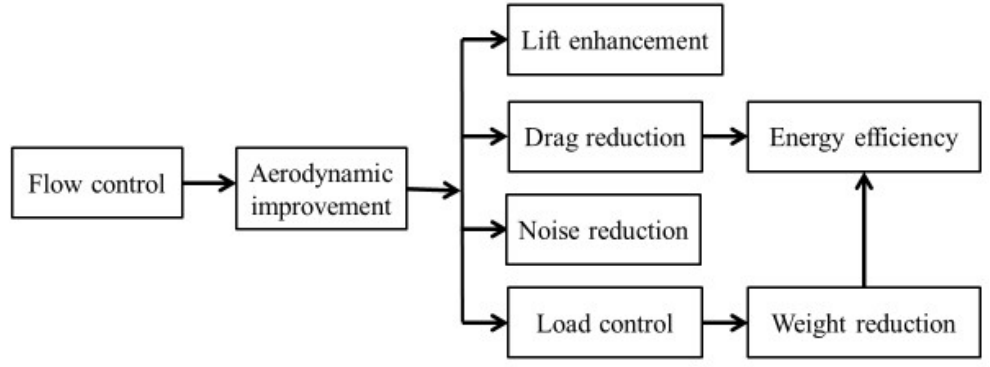
Figure 1. Relationship among flow control, load control and energy efficiency.